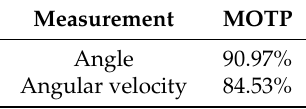
Figure 7. Measured and estimated results of our tracker for the right leg of one participant in HuGaDB dataset who was a 24-year old male with 177 cm stature and 75 kg body mass. ( a ) indicates ω H ( b ) compares the ω K between the tracker and the dataset. 1 Table 1. Evaluation metrics for tracking all 40 participates in HuGaDB dataset.